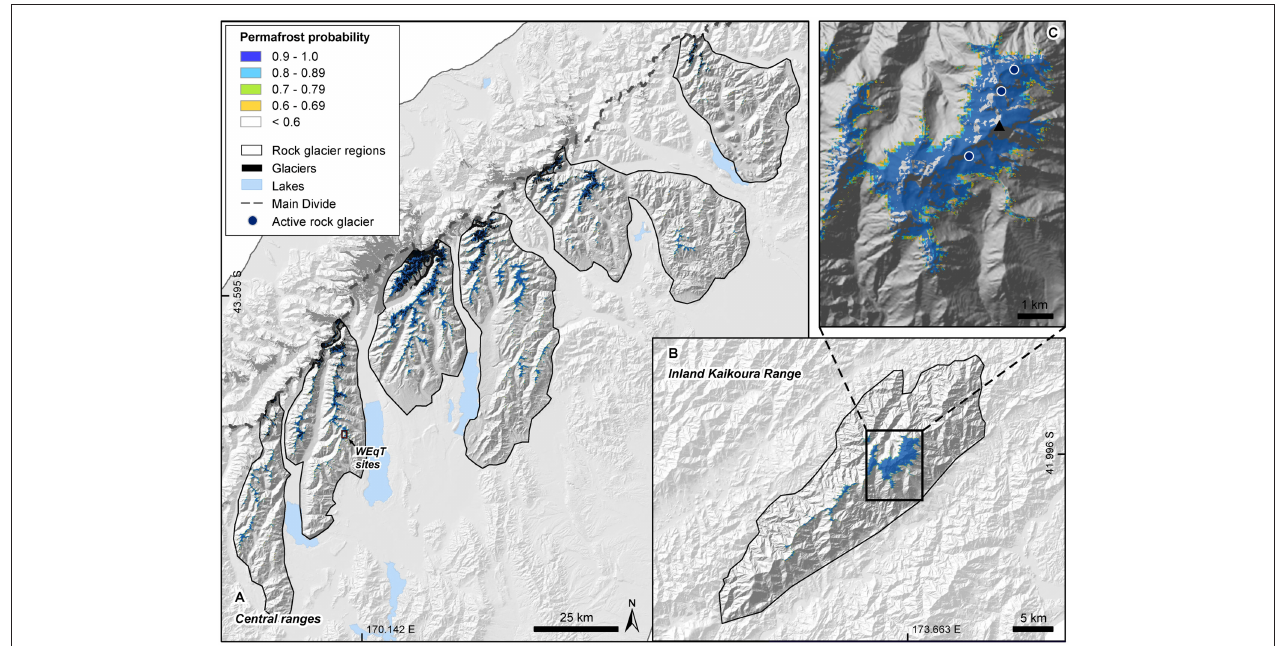
FIGURE 6 | Permafrost probability distribution in the central rock glacier regions (A), the Inland Kaikoura Range (B), and the Tapuae-o-Uenuku ( N ) area (C). In panel (A) , the rectangle signifies the location of the winter equilibrium temperature (WEqT) measurement sites. In panel (C) , rock faces are masked by removing areas with a gradient ≥ 40 ◦ from the probability layer. Glacier extent: Randolph Glacier Inventory 5.0 (GLIMS/NSIDR, 2015), background: hillshade of 25m DEM, Barringer et al. (2002).